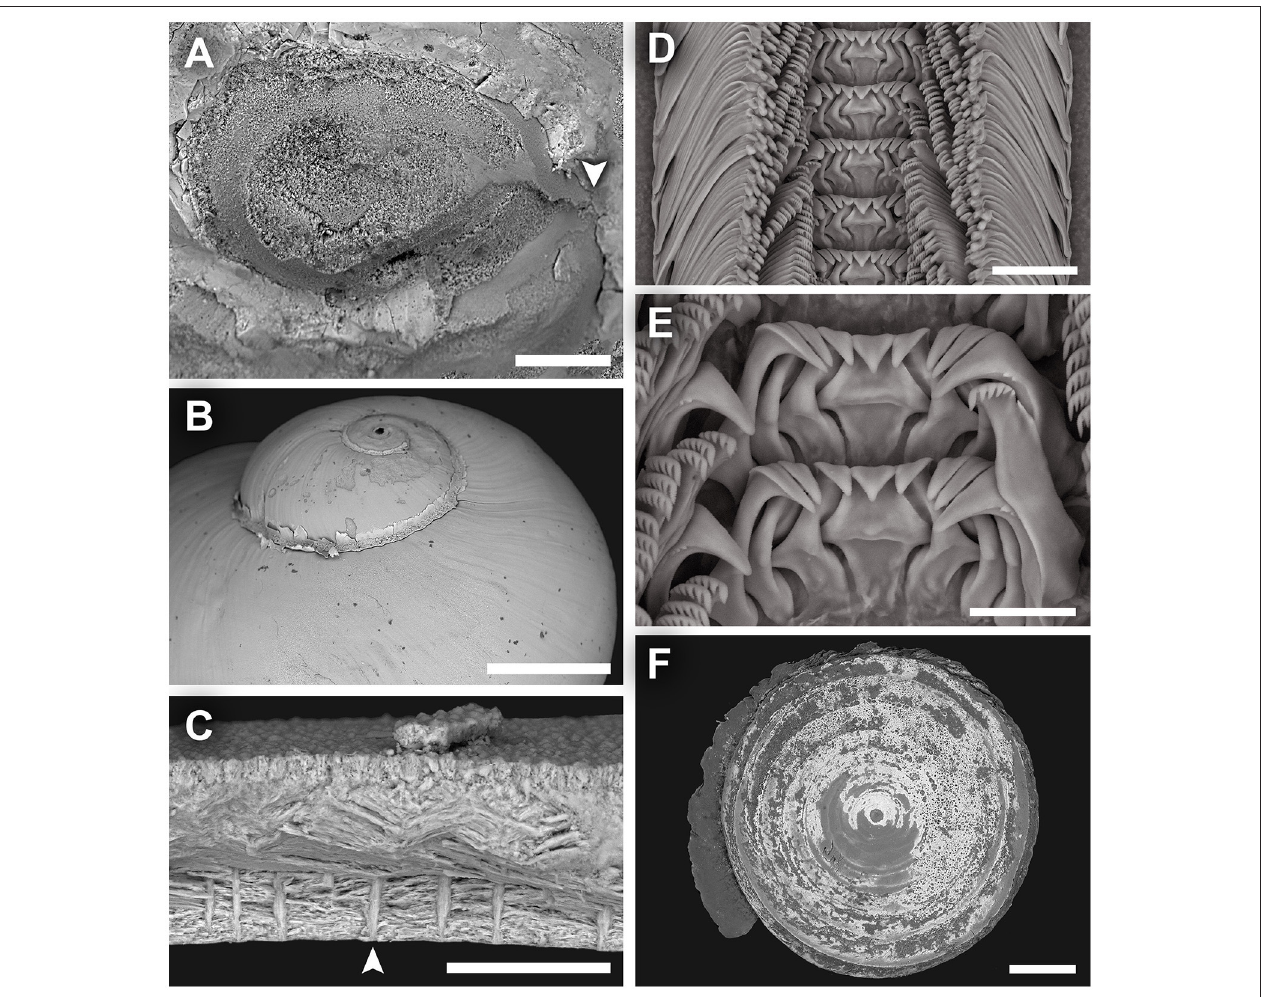
FIGURE 6 | Dracogyra subfuscus n. gen., n. sp. scanning electron micrographs. (A) Protoconch, (B) Shell surface of the upper half of the shell, as seen from the abapertural view, (C) Shell microstructure, (D) Radula, (E) Close-up of central and lateral teeth, (F) Operculum. Scale bars: (A) 50 µ m, (B, F) 0.5mm, (C) 30 µ m, (D–E) 25 µ